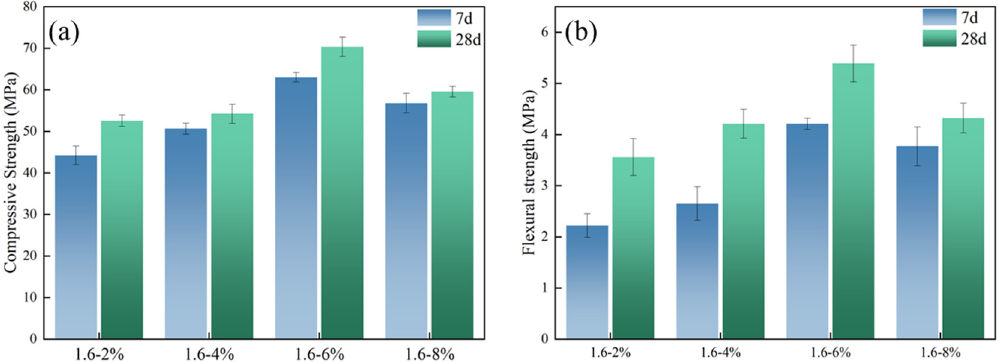
Figure 4. Effect of alkali content on mechanical properties of slag-based geopolymer: ( a ) Compressive strength; ( b ) Flexural strength.